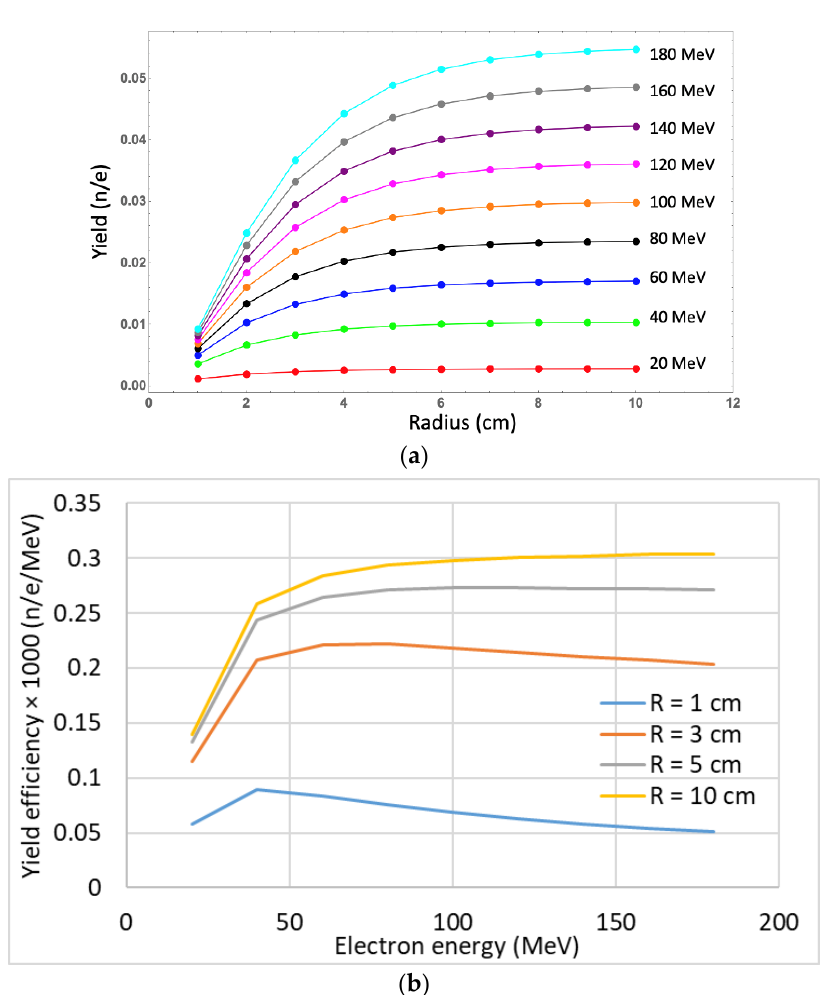
Figure 3. Neutron yield per electron for various electron energies and radius of a lead sphere ( a ), with electrons that are sourced at the sphere origin. The efficiency of neutron generation as a function of electron energy ( b ), for selected lead sphere radii.